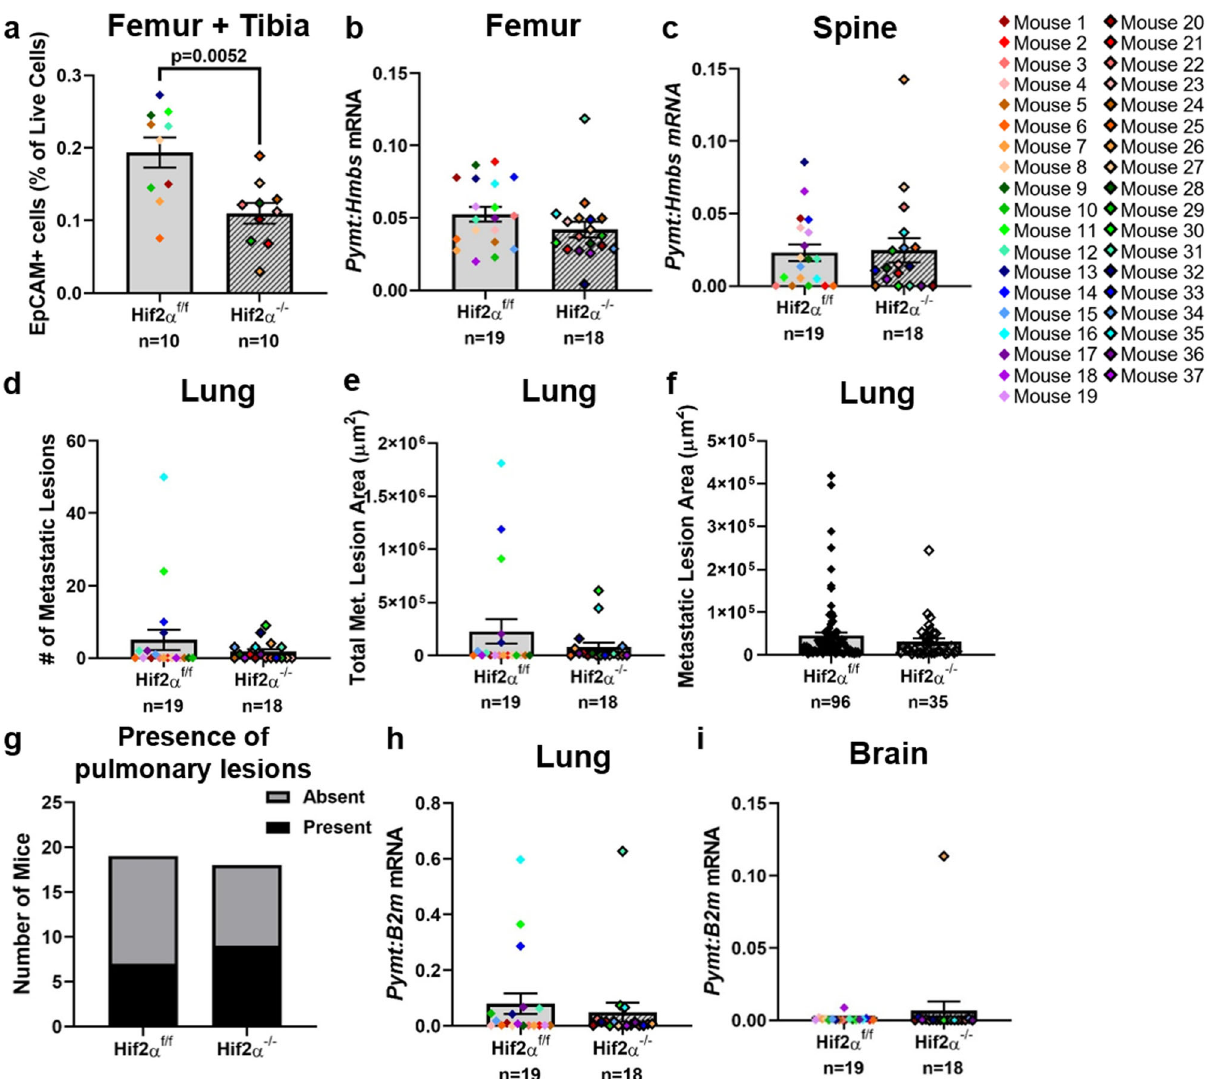
Fig. 5 Deletion of Hif2 α decreases tumor dissemination to the bone but not to the lung. a The percentage of EpCAM + cells, out of the total number of live cells, detected by fl ow cytometric analysis of left hindlimb bone marrow. Two-tailed Mann – Whitney test. n = 10 Hif2 α f/f PyMT + or Hif2 α − / − PyMT + mice. b , c Quantitative PCR analysis of Pymt transcript compared to Hmbs from right femur or spinal midsection, respectively. Two-tailed Mann – Whitney test. d , e Metastatic lesion number or area detected by histological analysis of H&E-stained sections from the left lung. Two-tailed Mann – Whitney test. f Comparison of individual lesion areas detected from histological inspection of left lung sections. Two-tailed Mann – Whitney test. n = 96 individual Hif2 α f/f metastatic lung lesions, n = 35 individual Hif2 α − / − metastatic lung lesions. g Comparison of the proportion of mice from each group that had any detectable pulmonary lesions. Fisher ’ s exact test. h , i Quantitative PCR analysis of Pymt transcript compared to B2m from the right lung or brain, respectively. Two-tailed Mann – Whitney test. Graphs represent mean per group and error bars represent s.e.m. For b – e , g – i , n = 19 Hif2 α f/f PyMT + mice, n = 18 Hif2 α − / − PyMT +